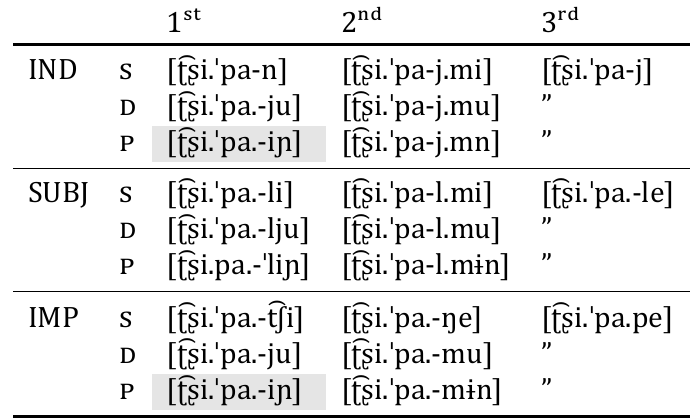
Table 13: Verbal paradigm for vowel-(cid:976)inal root [ʈ͡ʂipa-] ‘exit’, after Lenz 1895-1897 and Augusta 1903. Exceptions to penultimate-mora stress greyed